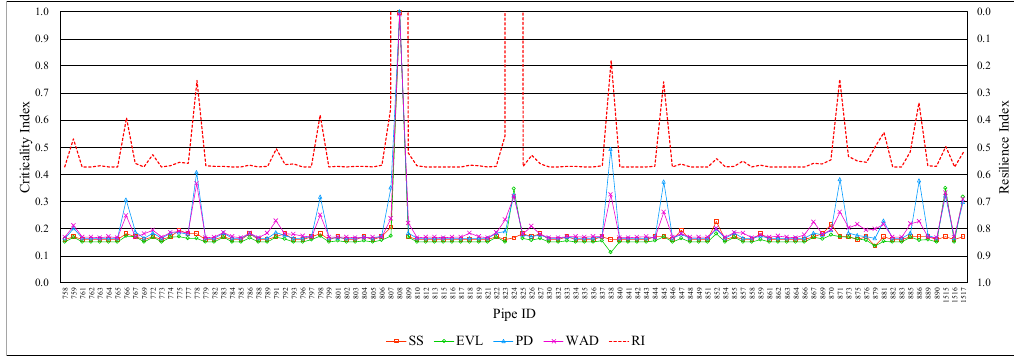
Figure 12. Comparison of the four criticality indexes with Resilience Index (RI) for Network 2.